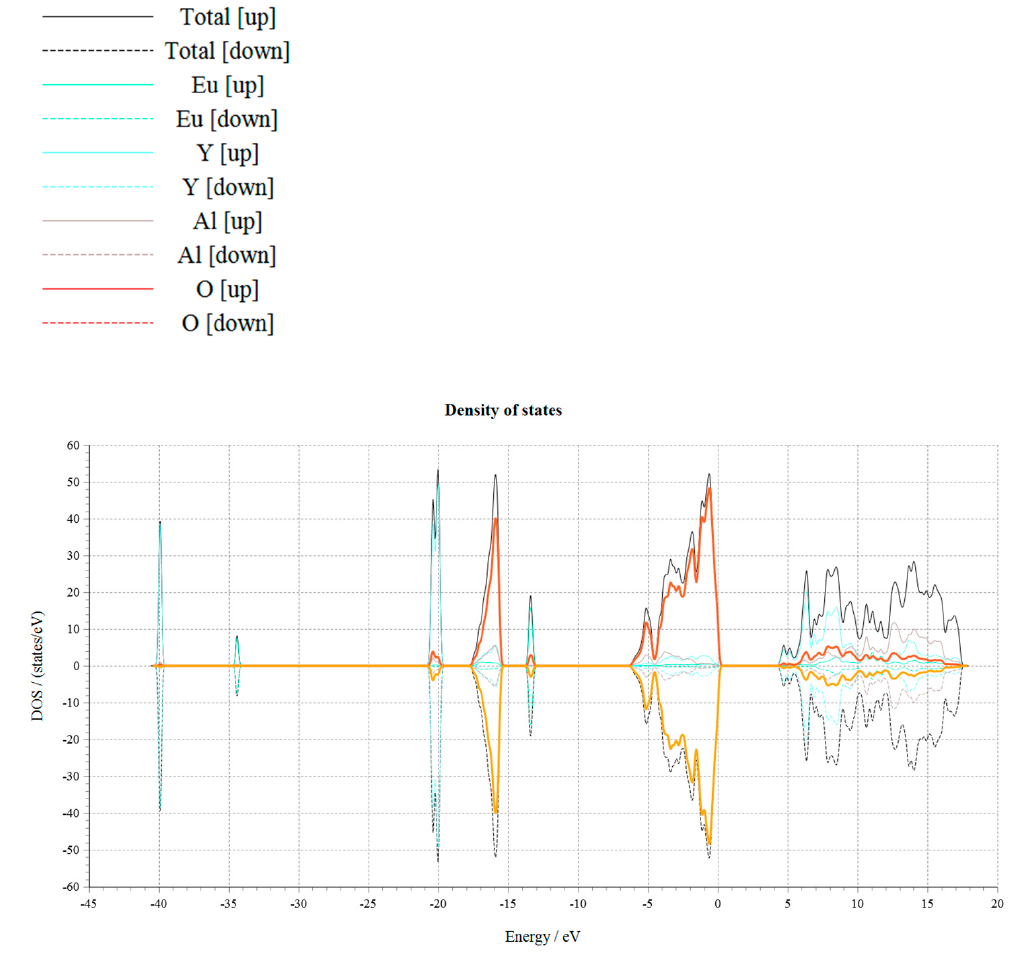
Figure 15. The density of states of YAG:Eu (two ions).